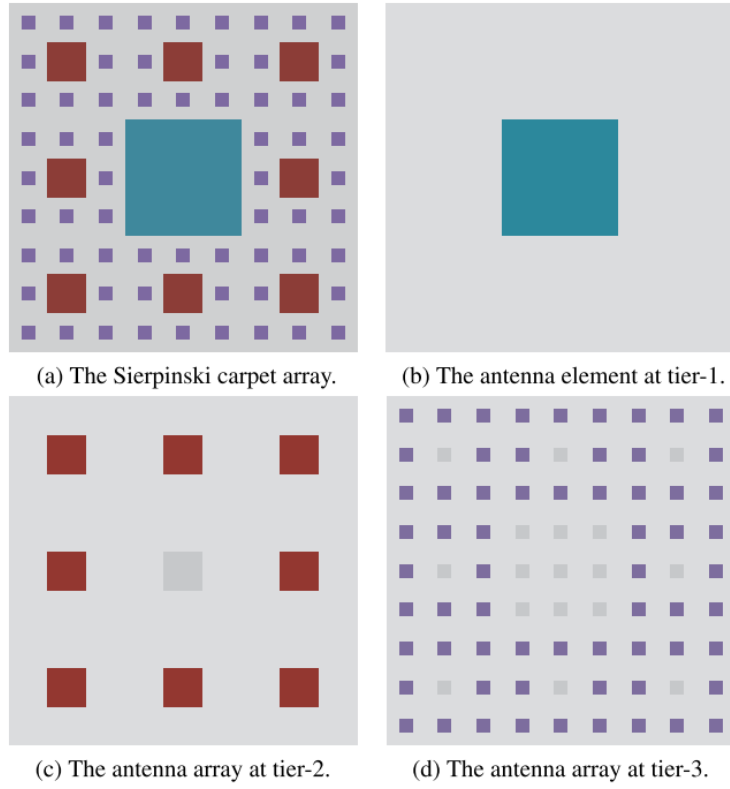
Figure 15. A Sierpinski carpet antenna array with three antenna tiers [65].